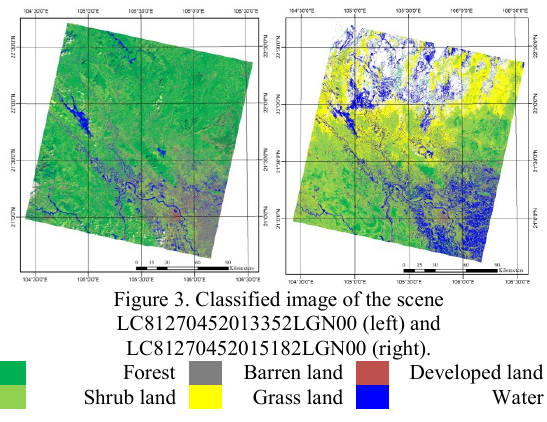
Figure 3. Classified image of the scene LC81270452013352LGN00 (left) and LC81270452015182LGN00 (right).